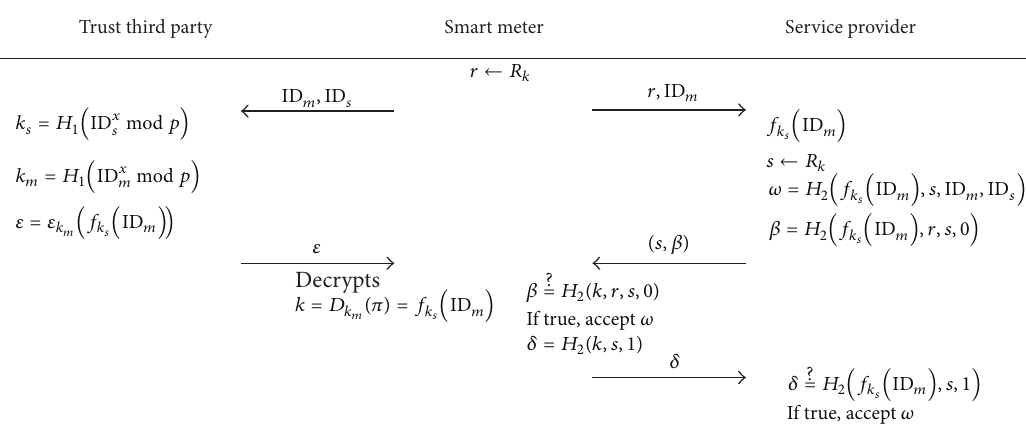
Figure 3: Xia and Wang’s proposed protocol.